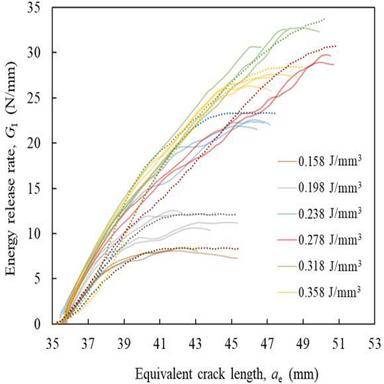
Experimental and numerical R-curves of SLS test specimens depending on EDV. Dotted-line refers to numerical data.